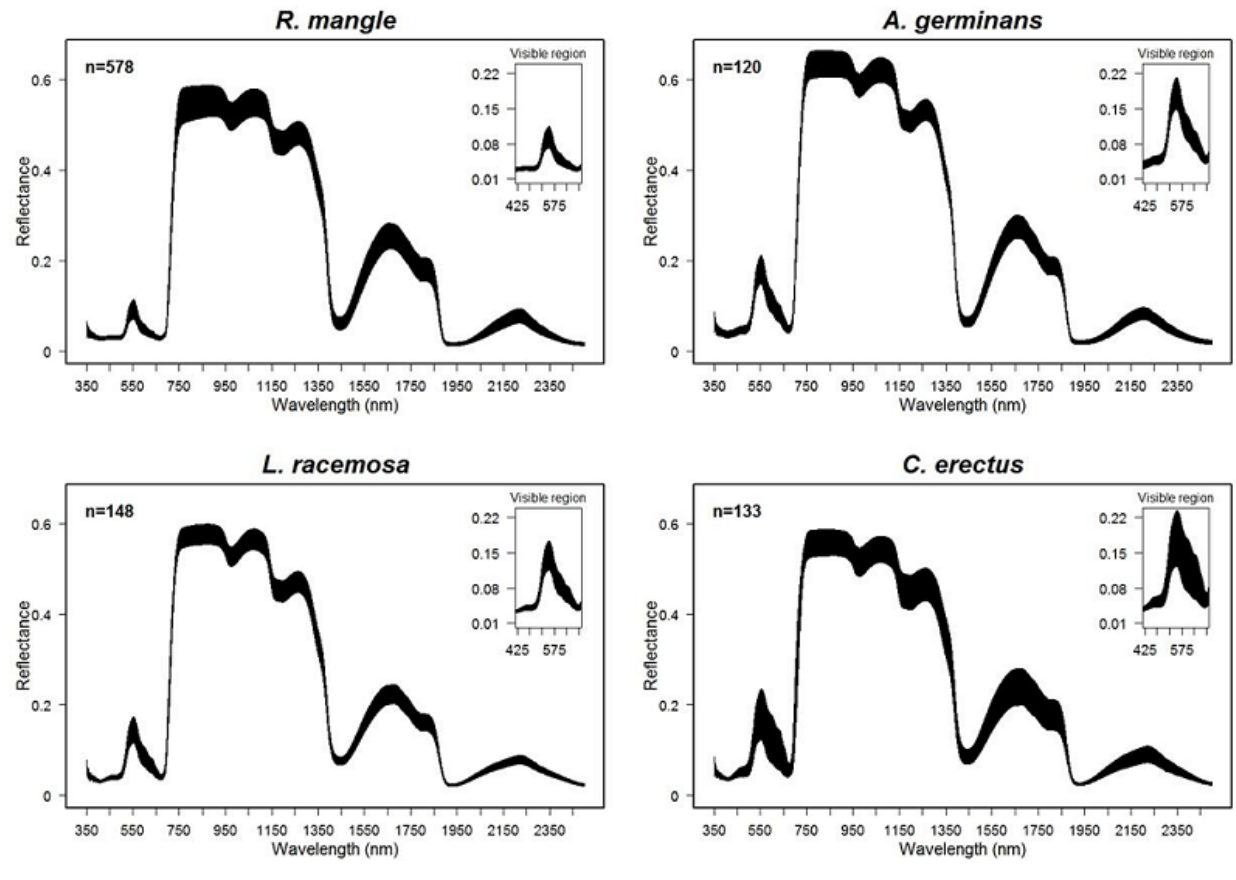
Figure 3. Spectral reflectance of mangrove species (mean ± SD). The smaller plots on the upper right corner represent a zoom in of the visible range of the spectrum. The visible region depicts features associated with differences in Chl ( μ g·cm − 2 ) among species. R. mangle , the species with the highest CC shows the lower reflectance in the visible part of the